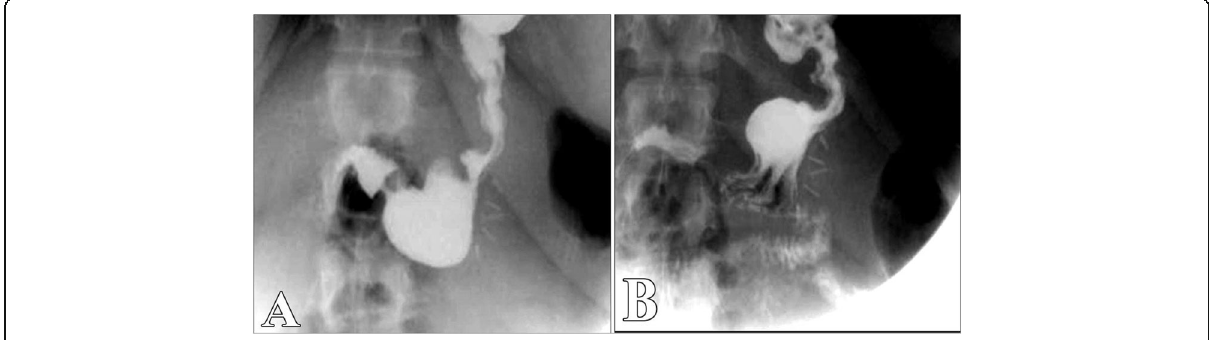
Fig. 3 A 37-year-old female patient underwent sleeve gastrectomy since 8 months came for follow-up. Diluted water-soluble upper gastrointestinal study: long tubular gastric tube and no evidence of leakage through the staple line. Diagnosis: essentially normal